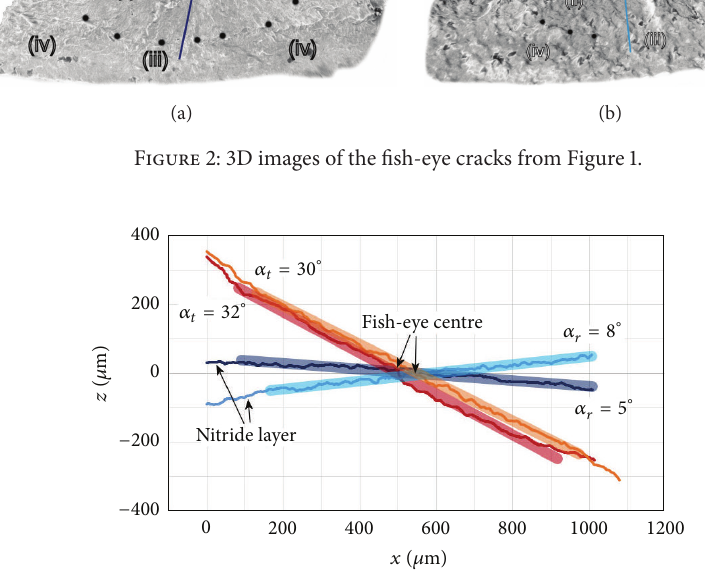
Figure 3: Profiles marked in Figure 2 with highlighted fish-eye segments.